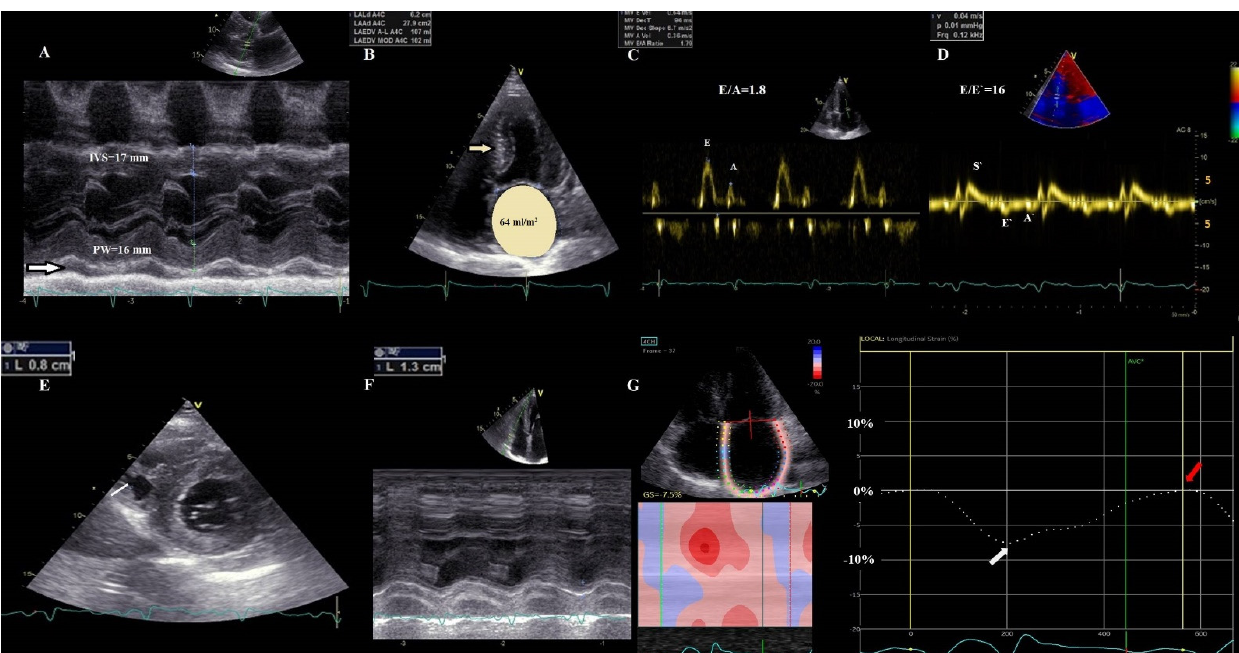
Figure 2. Transthoracic echocardiographic images in advanced ATTR-CM . ( A ) M − mode paraster- nal long-axis view of the LV displaying concentric severe LV hypertrophy (LV mass = 157 g/m 2 , RWT = 0.8), with mild pericardial effusion (white arrow); ( B ) apical 4-chamber view demonstrating a sparkling texture of the IVS and severely dilated LA (64 mL/m 2 ); ( C ) Pseudo normal transmitral filling pattern (E/A = 1.8); ( D ) TDI tracing of the mitral annulus showing that all tissue velocities are <5 cm/s, with increased E/E’ ratio. ( E ) parasternal short axis view showing biventricular hypertro- phy—RV free wall = 8 mm; ( F ) RV severe systolic dysfunction (TAPSE = 13 mm) ( G ) LA speckle- tracking showing significantly decreased pump function (white arrow) and even more severe res- ervoir function (red arrow), with the absence of conduit function. RWT, relative wall thickness, E = early filling velocity; A = late atrial filling velocity; S’, systolic TDI velocity; E’, early diastolic TDI velocity; A’, late diastolic TDI velocity; LA, left atrium; LV, left ventricular; RV, right ventricular; TAPSE, tricuspid annular plane systolic excursion; STE, speckle tracking echocardiography. Other echocardiographic signs suggestive of CA include pericardial effusion, right ventricular (RV) hypertrophy, and atrial septal and valve thickening. [9] RV dilation may occur late in the disease and carries a poor prognosis. None of the previously cited pa-